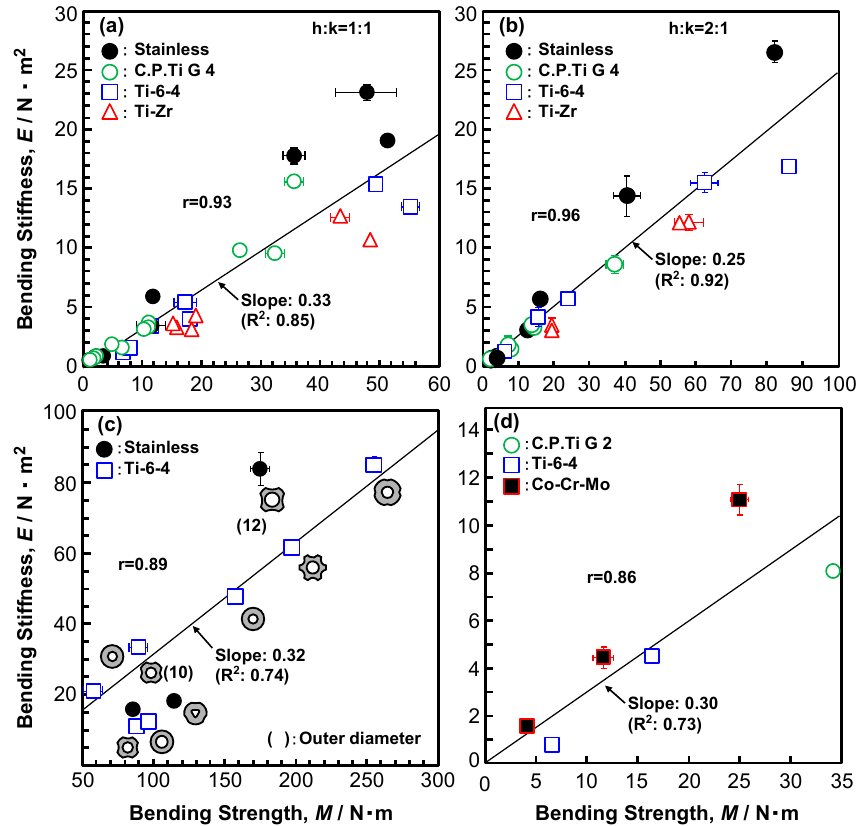
Figure 3. Relationship between bending stiffness and bending strength obtained from four-point bending tests. ( a ) bone plates (h:k = 1:1), ( b ) Bone plates (h:k = 2:1), ( c ) intramedullary nail rods, and ( d ) spinal rods.